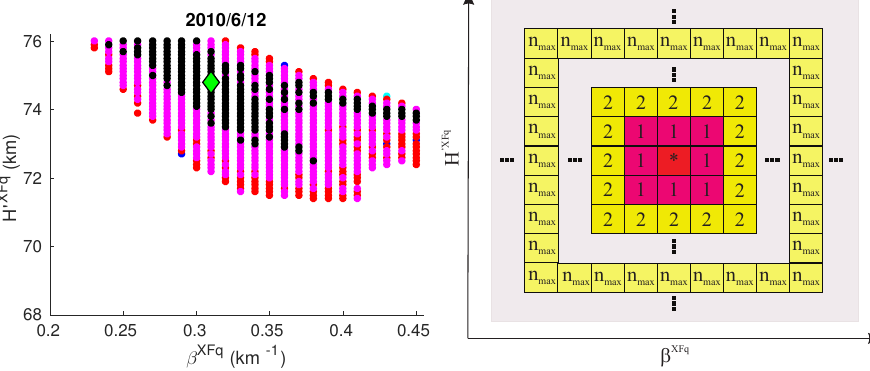
Figure 4. Left panel: Visualization of pairs of Wait’s parameters “sharpness” and signal reflection height ( β XFq , H (cid:48) XFq ) in quiet state q that satisfy conditions given by Equations (6) and (7) for an X-ray flare XF occurred on 12 June 2010. The color of each point denotes the category of the corresponding pair. Each category includes pairs having all the four relative errors lower than c · 10% (see Equation (A1)). Colors black, magenta, red, blue and cyan indicate the c-values increasing from ) which provides 1 to 5 in steps of 1. The green diamond indicates the pair ( β XFmidday , H (cid:48) XFmidday 0 0 the best agreement of modeled and recorded amplitude and phase changes for the considered X-ray flare. Right panel: Region of Wait’s parameter space around the point "*" with the visualization of the neighbor system. The first neighbors ( n = 1) are colored pink, the second ones ( n = 2) orange, and the most distant neighbors considered in the procedure ( n = n max ) are colored